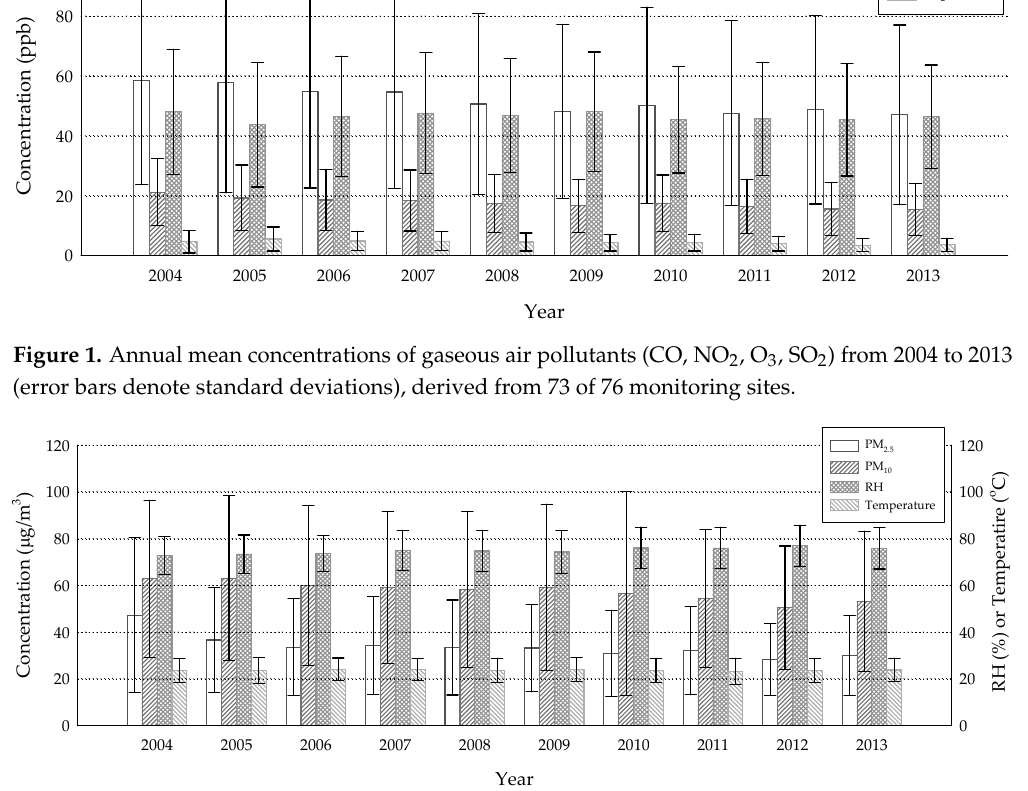
Figure 2. Annual averages of particulate matter with aerodynamic diameter ≤ 2.5 and 10 µ m (PM 2.5 and PM 10 ) concentrations, relative humidity (RH) and temperature from 2004 to 2013 (error bars denote standard deviations), derived from 73 of 76 monitoring sites.